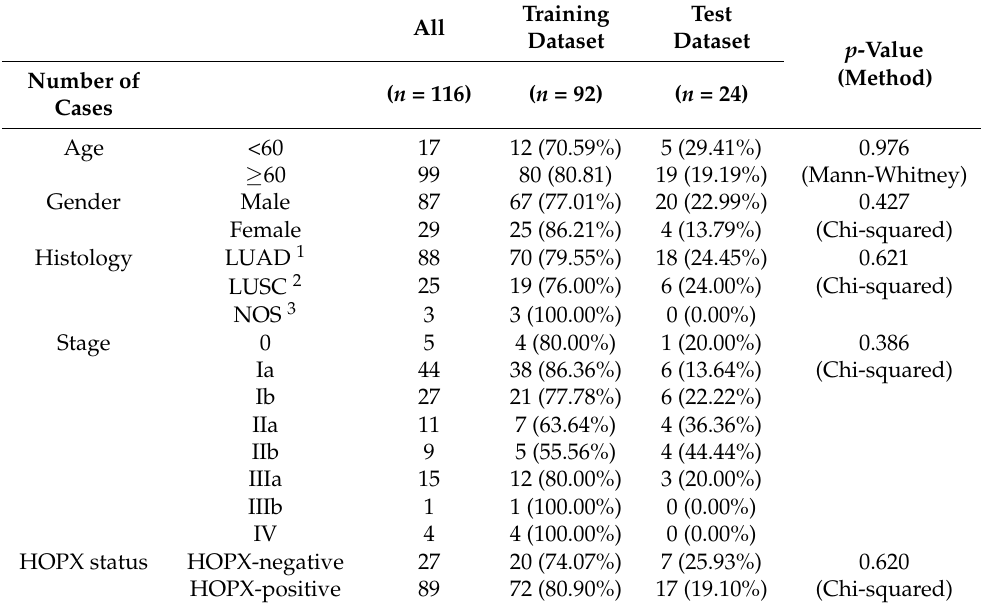
Table 1. Patients’